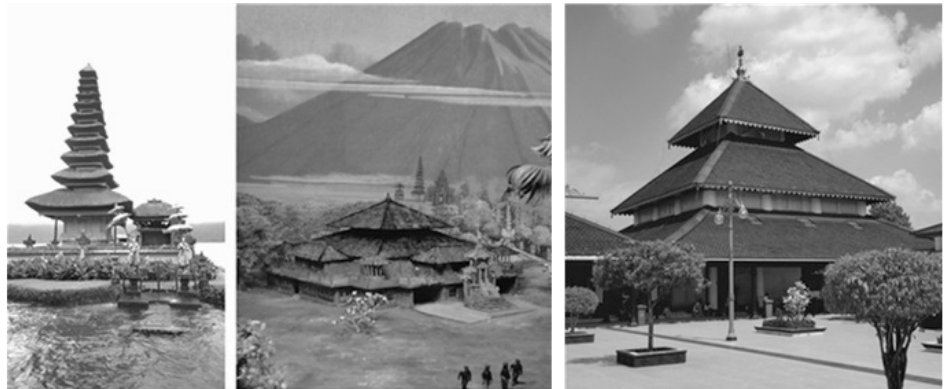
Figure 5. The Balinese pura (left) and wantilan (middle) have been adopted by the three tiers roof of Demak mosque